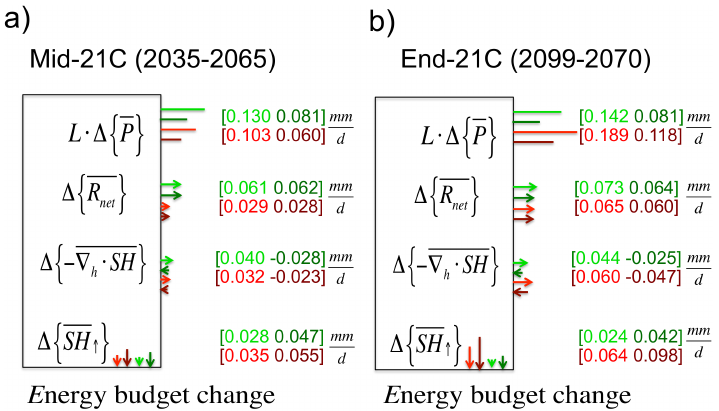
Fig. 9. Schematization of the two distinct mechanisms characterizing the diverse strengthening of the hydrological cycle in (a) mid- and (b) end-21C. The atmospheric energy balance perturbation is the same as in Fig. 3b (left box) and colored numbers/arrows indicate precipita- tion change and the corresponding contributions to the energy balance coming from each term. Land averages (light colors) and sea averages (dark colors) are for A1B (red) and E1 (green). Table 2. E1 vs. A1B contributions to rainfall change coming from surface evaporation (Evap) and atmospheric moisture convergence (Moist Conv) for (upper rows) 2035–2065 (mid.21C) and (lower rows) 2071–2100 (end-21C) with respect to 1970–2000 climatol- ogy. Global land (ocean) averages in left (right) columns for each contributing